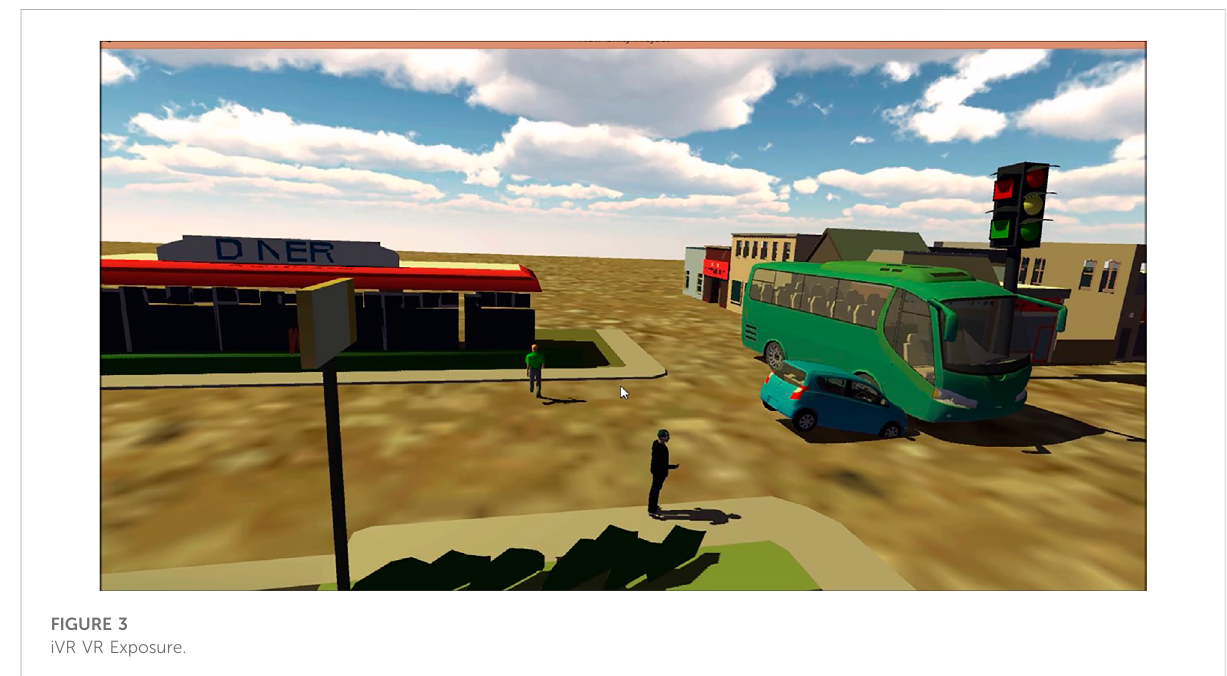
FIGURE 3 iVR VR